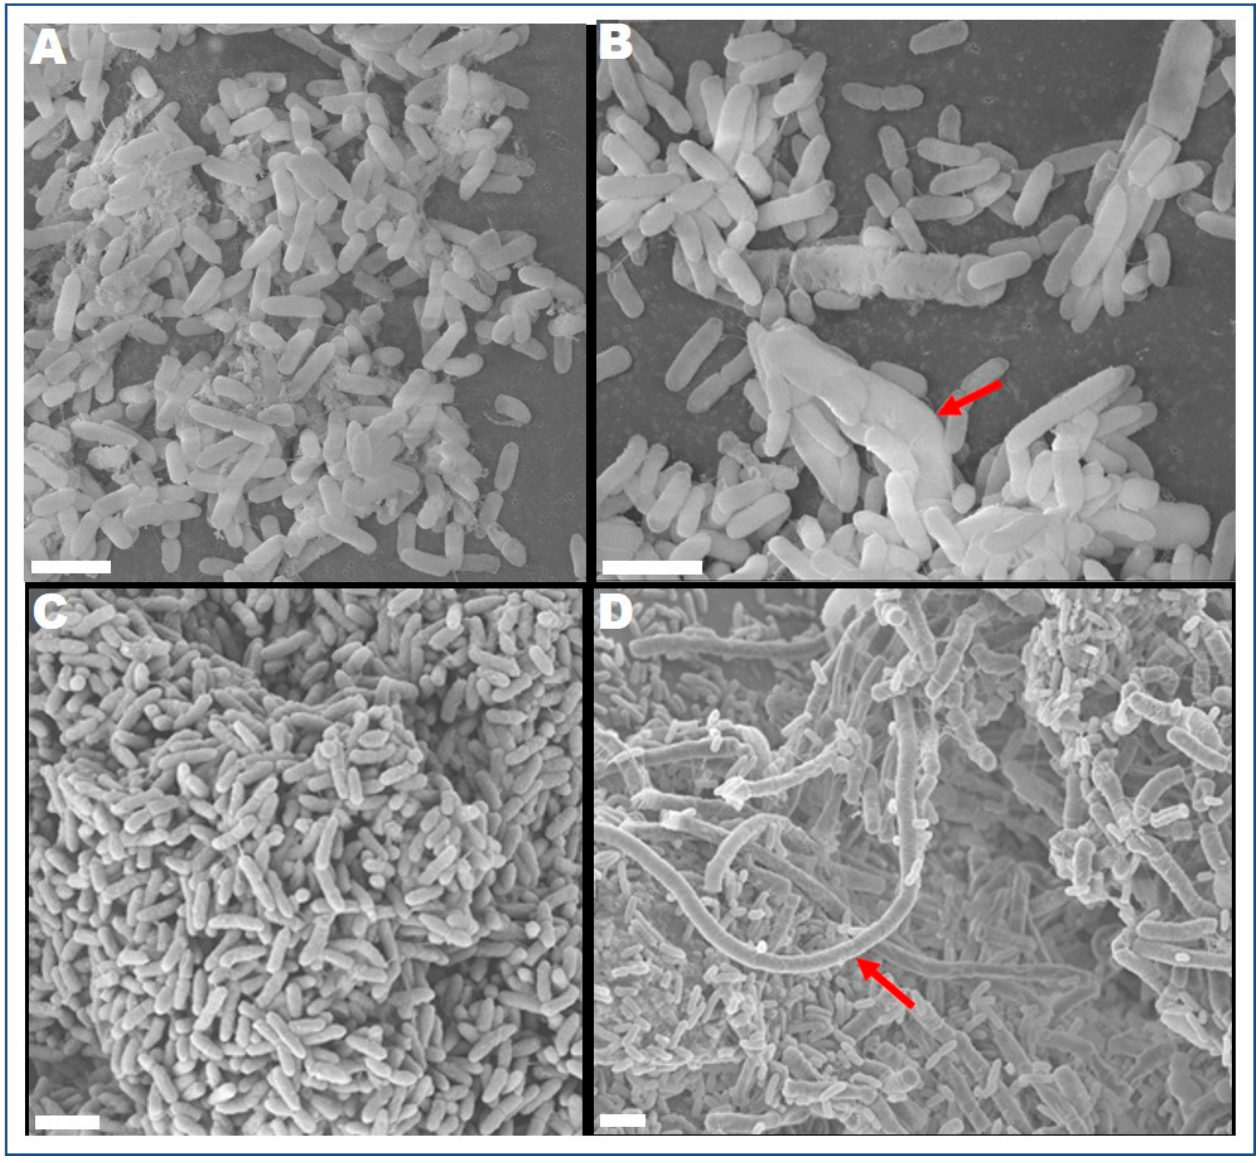
Figure 1. FESEM images of P. aeruginosa PAO1 biofilm cells after 144 h. The scale bar in all the images corresponds to 2.0 µm. ( A ) Air–liquid interface biofilm grown with control catheters, ( B ) air–liquid interface biofilm grown with antibiotic-impregnated catheters (Arrow indicates a swollen cell), ( C ) biofilm cells on control catheters and ( D ) biofilm cells on antibiotic-impregnated catheters (Arrow indicates an elongated cell).